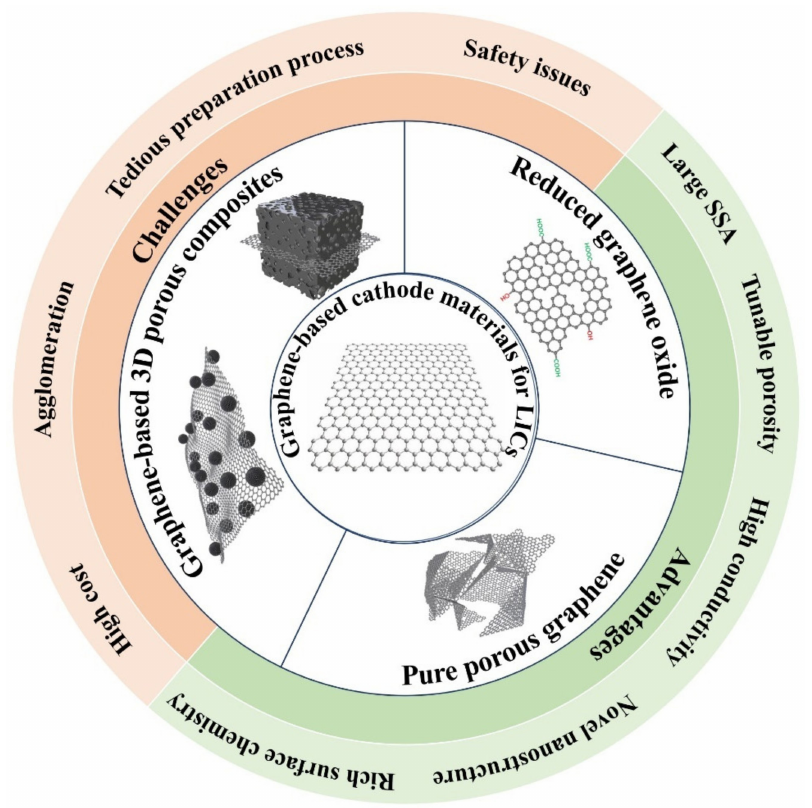
Figure 2. Typical graphene-based cathode materials for LICs and their advantages and the remaining